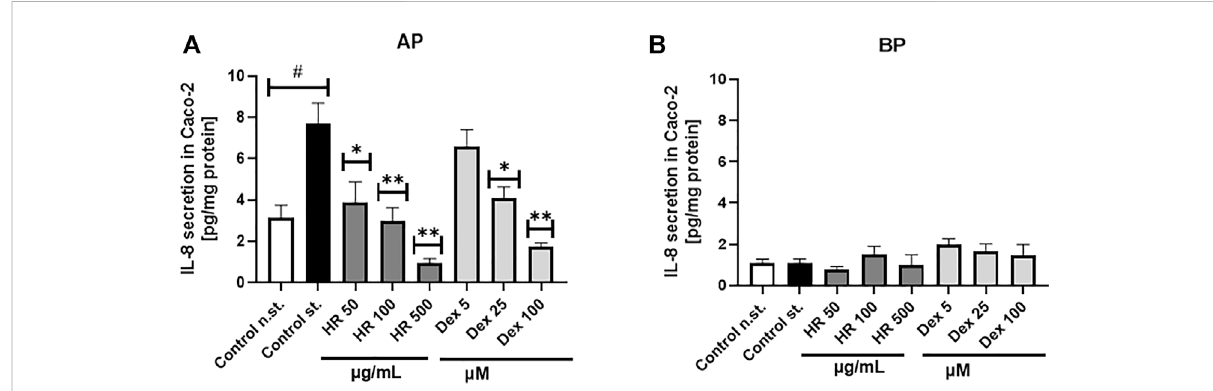
FIGURE 2 Effect of HR on IL-8 secretion by Caco-2 (pg/mg protein ± SEM) in the apical (A) and basolateral (B) side of Caco-2 monolayer after the HR application. HR — aqueous extract from the fruit of Hipopphaë rhamnoides ; Dex — dexamethasone; st. — mixture of IL-1 β /TNF- α /IFN- γ /LPS. # p <